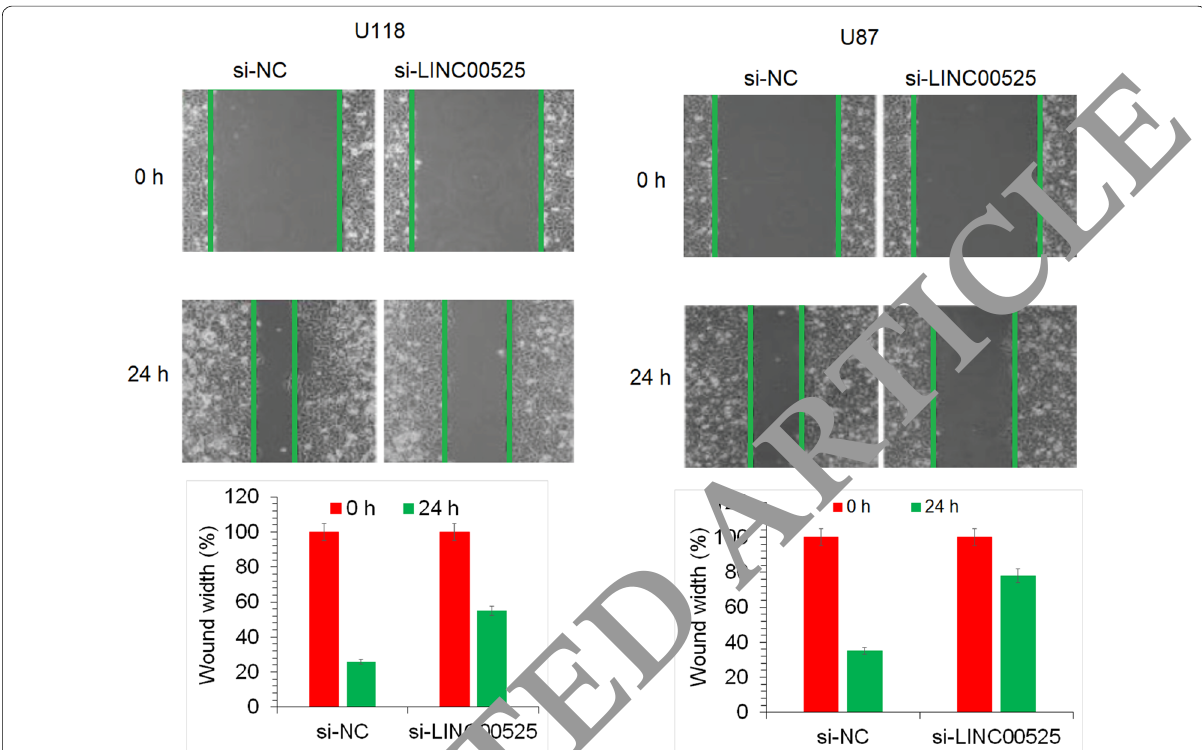
Fig. 3 lncRNA-LINC00525 knockdown restricts the glioma cell migration. Analysis of migration U87 and U118 cancer cells transfected with si-NC or si-LINC00525 by wound-heal assay. The experiments were performed in triplicate and expressed as mean